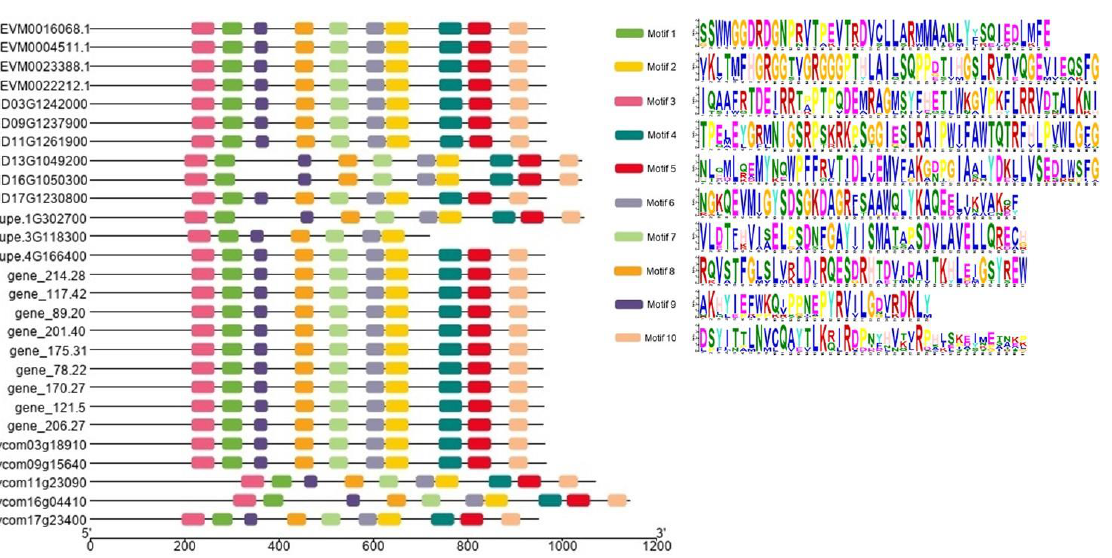
Figure 3. Conserved motifs identified in PEPCs of five Rosaceae